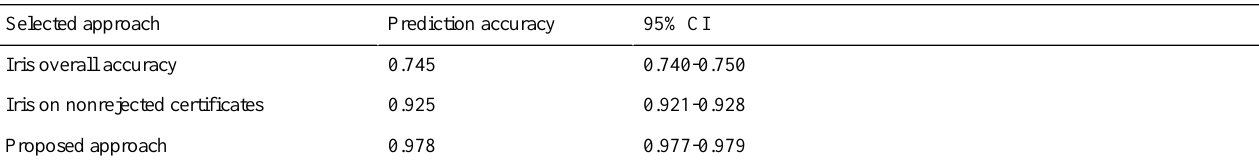
Table 1. Prediction accuracy of Iris and the best derived predictive model derived by